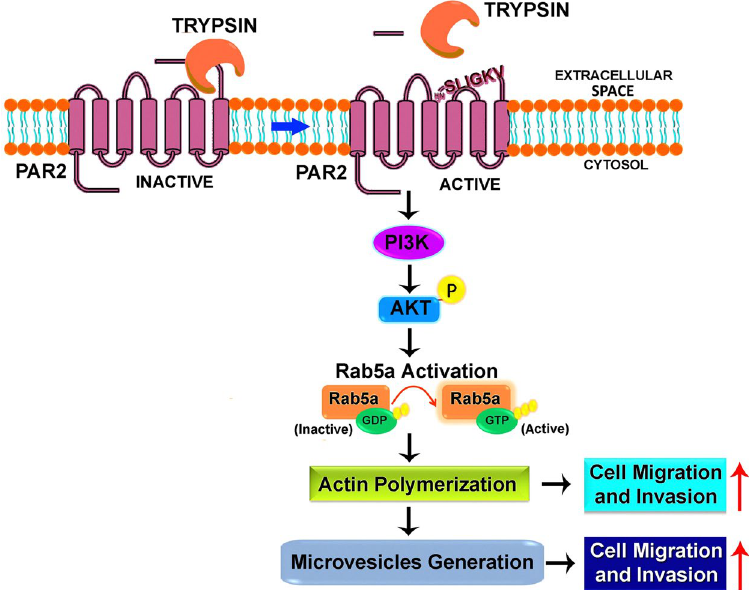
Figure 8. Schematic Diagram Showing That Trypsin Mediated PAR2 Stimulation Promotes Pro-migratory And Pro-invasive MVs Generation via Rab5a Activation. The activation of PAR2 by trypsin triggers PI3K-dependent AKT phosphorylation at Serine 473. This induces the activation of Rab5a from inactive GDP-bound form to active GTP-bound state resulting in actin polymerization which is critical for MVs generation. Rab5a activation also leads to cell migration and invasion. These MVs have the potential to induce cell migration and